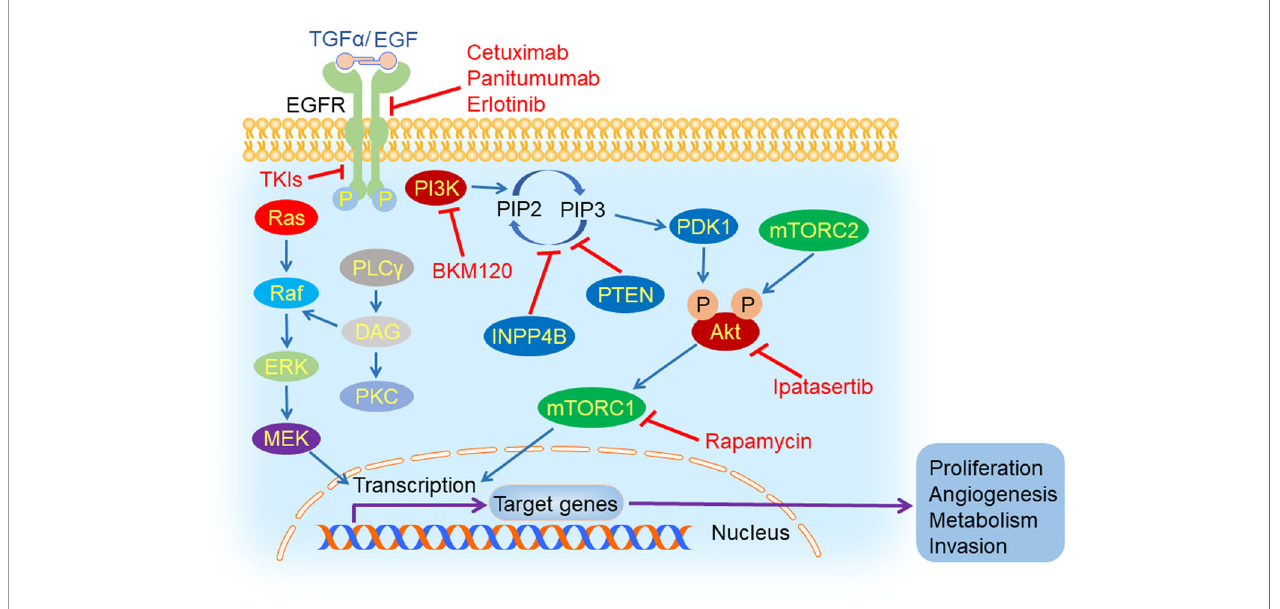
FIGURE 3 | EGFR and its downstream signaling pathways inhibition in TNBC. Epidermal growth factor receptor (EGFR) could be activated by its ligand EGF or transforming growth factor a (TGF a ). After its activation, it can dimerize with all members of HER family and create homo- or hetero-dimers, triggering a myriad of downstream signaling pathways, such as PI3K/Akt/mTOR, Ras/Raf/MEK/ERK and PLC g /PKC. EGFR inhibitors (cetuximab, TKIs, panitumumab, and erlotinib), PI3K inhibitor (BKM120), mTORC1 inhibitor (rapamycin) and Akt inhibitor (ipatasertib) could hamper tumorigenesis and tumor progression by suppressing the process of signal